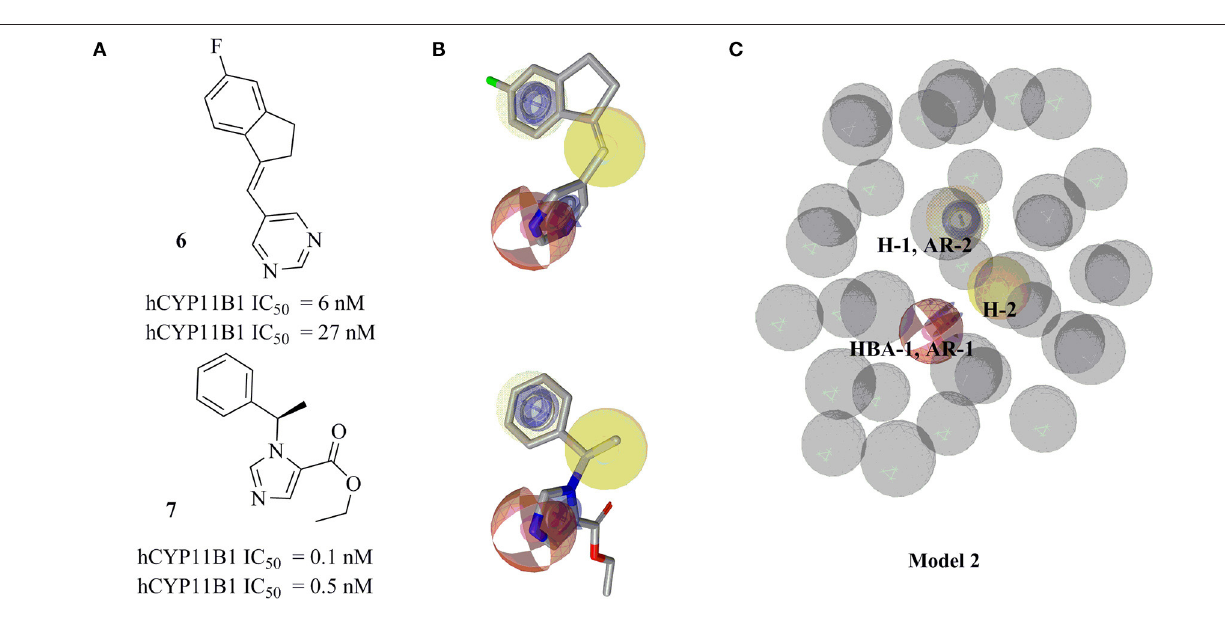
FIGURE 4 | Pharmacophore model 2 with its training compounds 6 and 7 . (A) Training compounds with their IC 50 values are drawn. (B) Mapping of training compounds with the model are shown. (C) The pharmacophore model is shown. Pharmacophore features are marked by colors. Model 2 comprised of 2 hydrophobic features, 2 AR features, 1 HBA feature, and 33